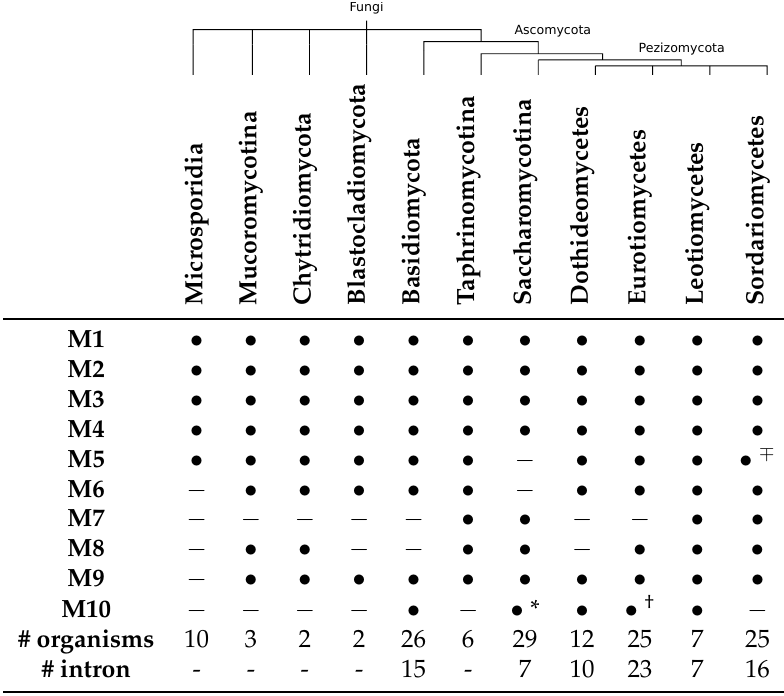
Figure 1. Variations in subclades are indicated as follows: * not present in Saccharomycetaceae; † not present in Penicillium ; ∓ not present in